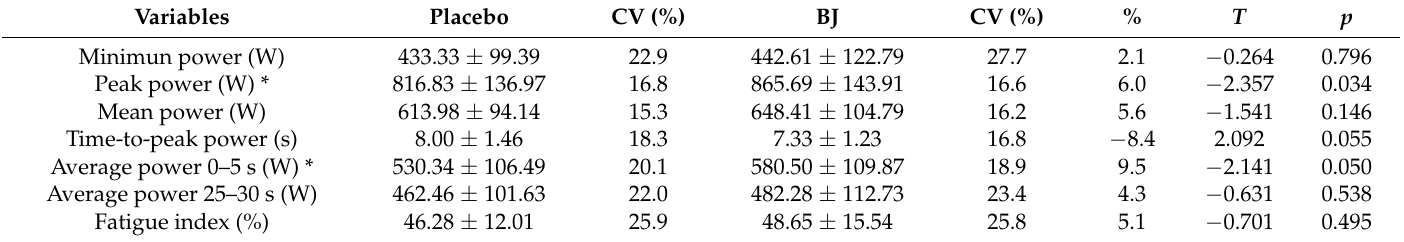
Table 3. Power variables recorded in the Wingate test in participants according to the experimental conditions (beetroot juice or placebo supplementation).